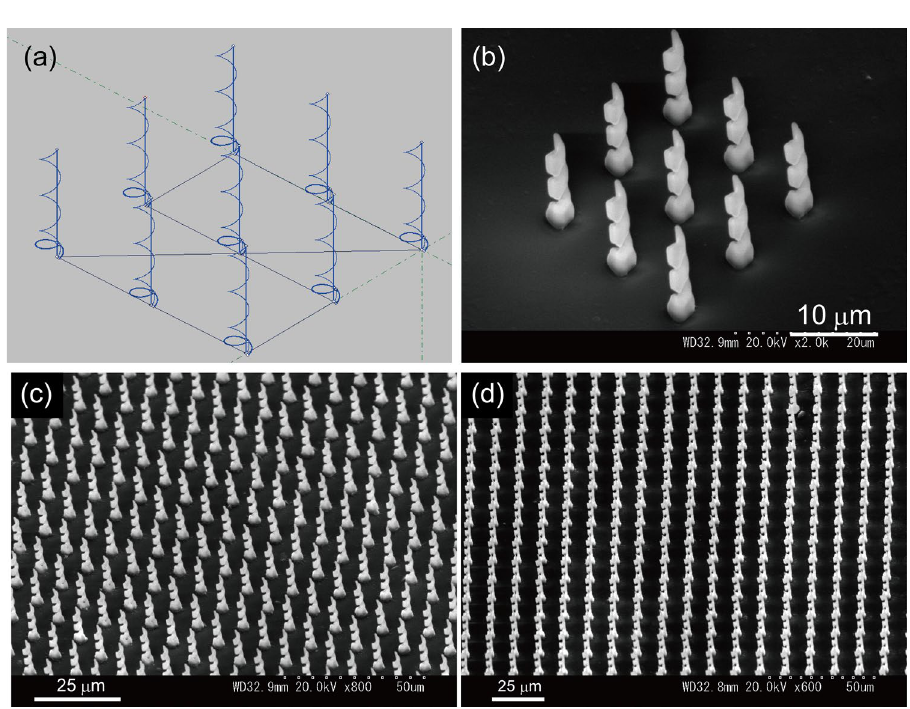
Figure 7. ( a ) Programmed pattern of 9 helical structures. ( b ) SEM image of 9 practically fabricated helical structures using the programmed pattern in ( a ). ( c , d ) SEM image of the helical structures fabricated in a wide area by repeating DLW of the 1900 helical structures (38 line × 50